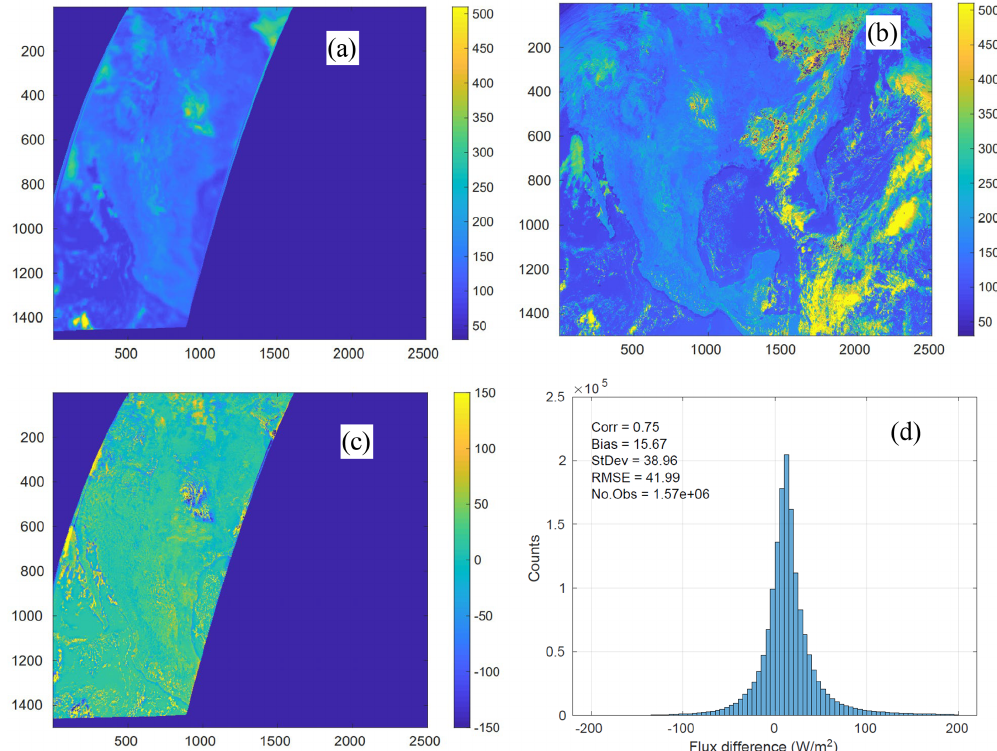
Figure 9. Comparison of TOA SW flux from ABI and CERES FLASHFlux for 25 November 2017 at 17:57Z: (a) CERES FLASHFlux Terra product, (b) results from ABI with “separate-channel” coefficients, (c) difference of ABI–CERES FLASHFlux, and (d) histogram of ABI–CERES FLASHFlux differences (this is the only case illustrated in this paper with data from FLASHFlux; Kratz et al., 2014).